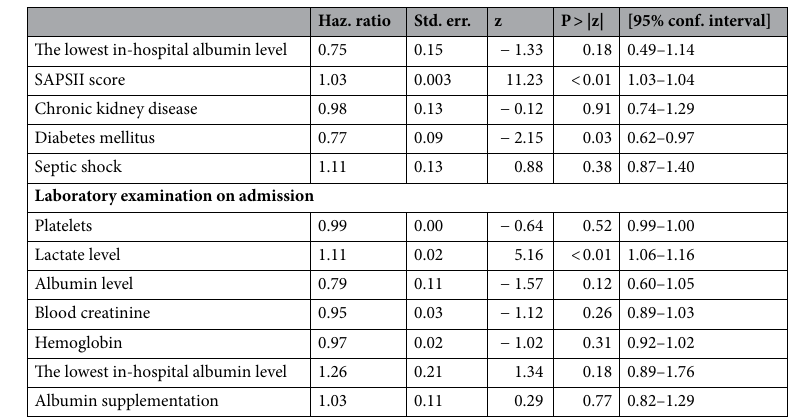
Table 2. Regression analysis of multivariate Cox ratio of the 28-day mortality rate at the lowest serum protein level.